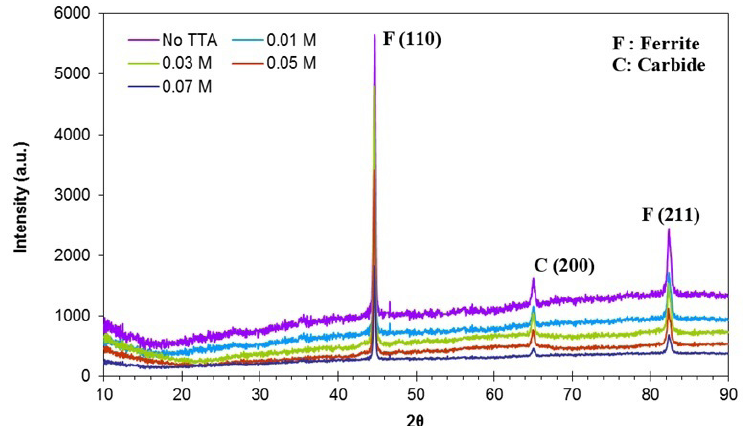
Figure 13. XRD pattern of mild steel surface after 2 h immersion in 0.5 M HCl containing different concentrations of TTA (a) blank, (b) 0.01 M, (c) 0.03 M, (d) 0.05 M, (e) 0.07